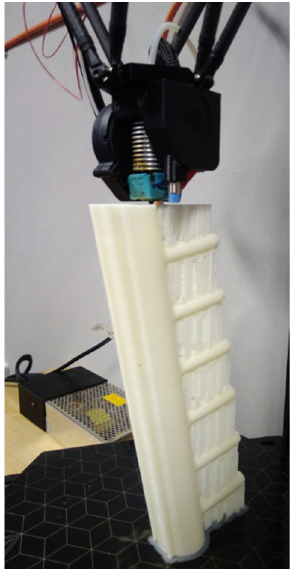
Figure 8. General view of n07 computational fluid dynamics (CFD) model. Monitoring surfaces were established at the central plane (light grey color), cross-sections in tubes (only the ones located in the first tube are shown), and points (detailed view on the right).